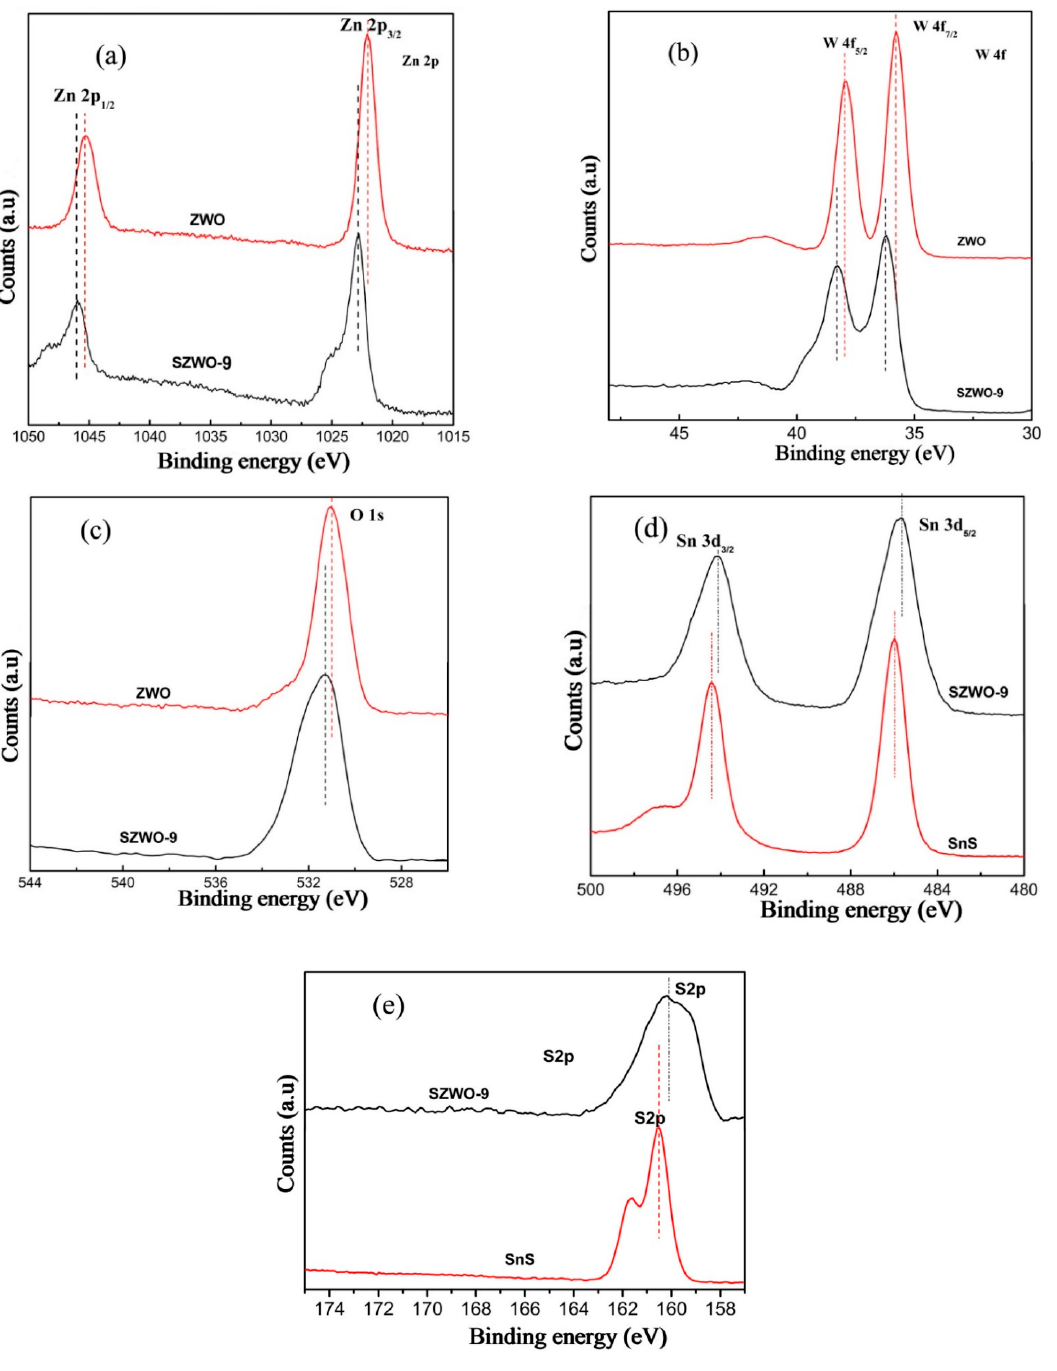
Figure 4. High resolution XPS spectra of the SZWO-9 sample, ( a ) Zn 2p, ( b ) W 4f, ( c ) O 1s, ( d ) Sn 3d; ( e ) S 2p.